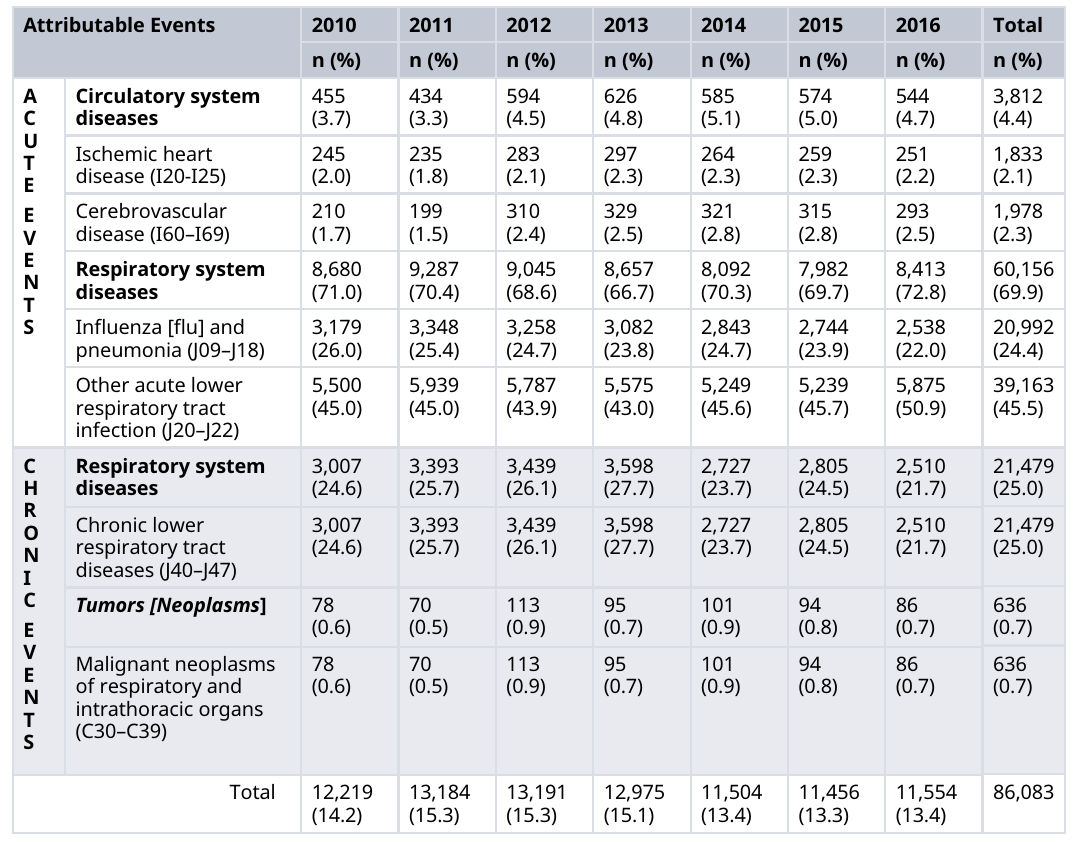
Table 2. Attributable prevalent cases to ambient PM 2.5 pollution,